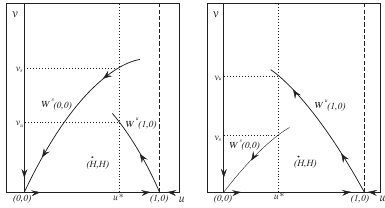
Figure 2. The intersection of W s (0 , 0) and W u (1 , 0) is not empty, giving rise to the heteroclinic curve joining the points (0 , 0) and (1 , 0) . The separatrix curve ¯ Σ , the straight line u = 1 and the u − axis determines a subregion ¯ Γ , which is closed and bounded, that is, ¯ Ψ = (cid:8) ( u, v ) ∈ ( R 2 / 0 ≤ u ≤ 1 , 0 ≤ v ≤ v s and ( u, v s ) ∈ ¯ Σ + )